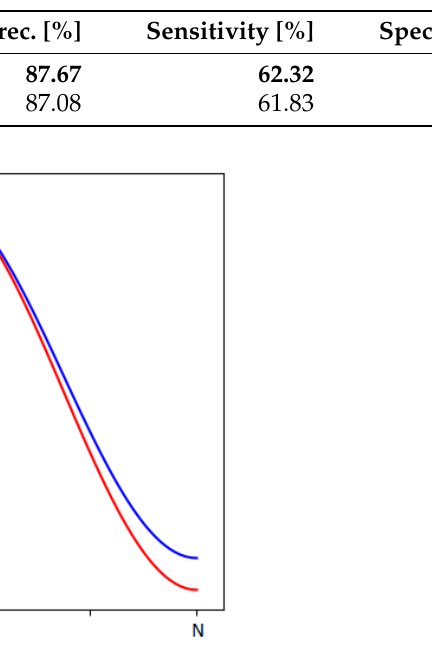
Table 4. The results of the linking model on the validation set, depending on the type of window function used. The data is from the best of the era. They were obtained by the fivefold cross-validation method.